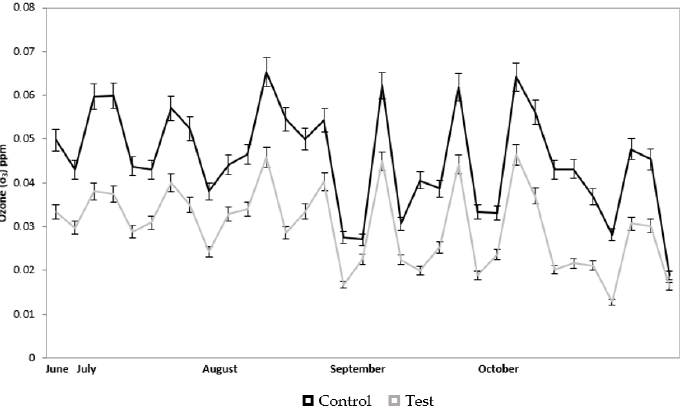
Figure 5. Daily average ozone (ppm) for test and control across all sites from June to October 2017.